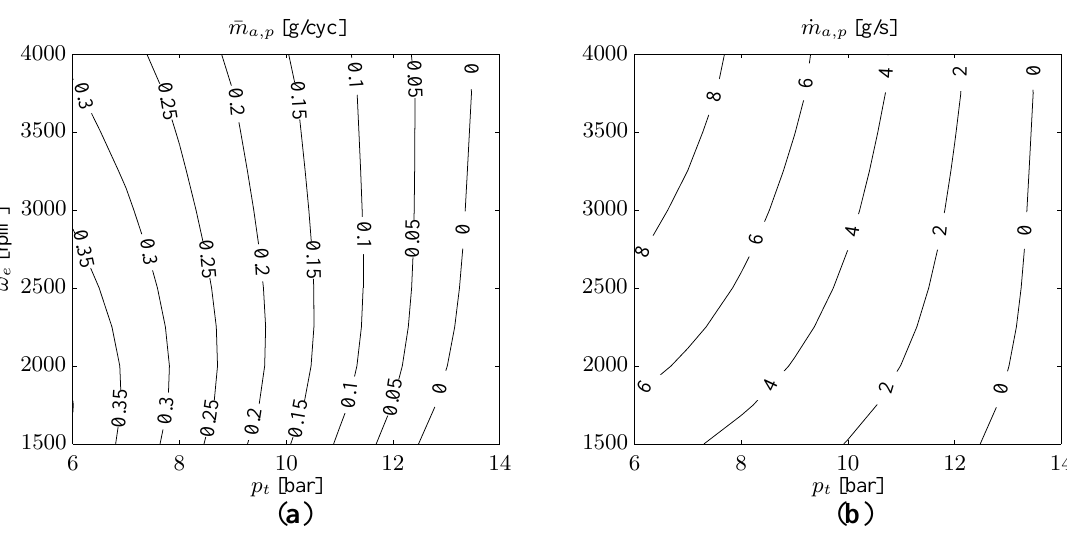
Figure 4. Pump mode performance. ( a ) Air mass transferred per cycle from cylinder to tank; and ( b ) mean air mass flow from cylinder to